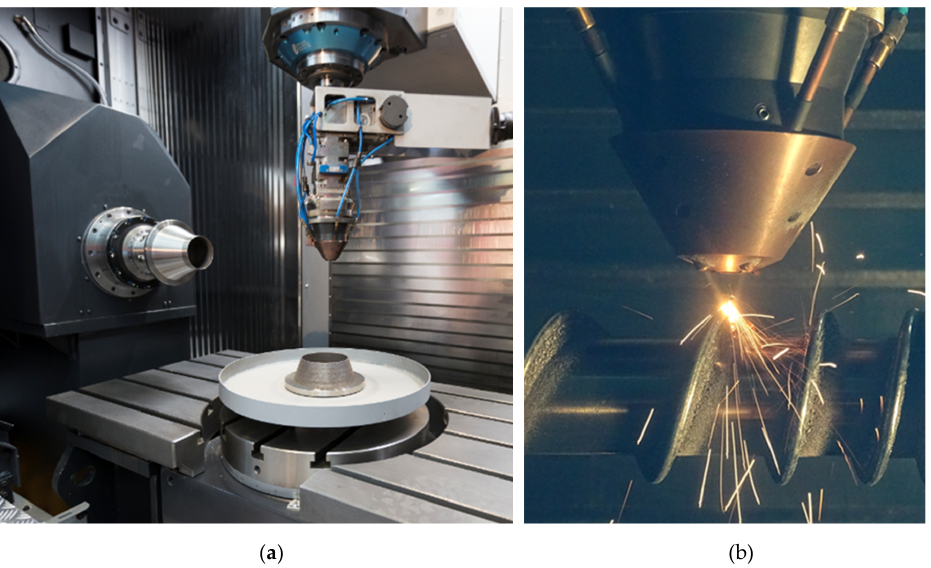
Figure 11. ( a ) IBARMIA ZVH45/1600 Add + Process hybrid machine; ( b ) four-stream discrete coaxial nozzle.